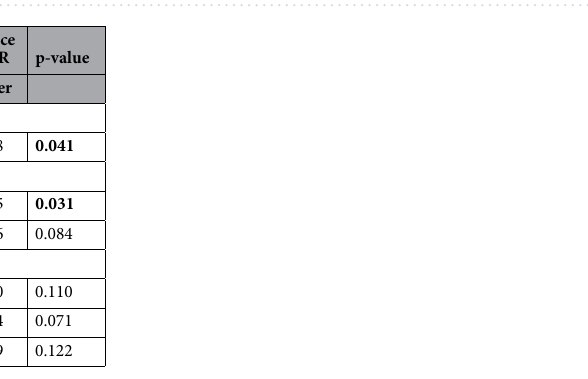
Figure 3. Total SRI, weekly SRI, and least square mean between relapse group and no relapse group. Total and Weekly SRI in relapsers (red) and non-relapsers (blue). ( A ). One-way plot showing total SRI (y-axis) in non- relapsers ‘0’ (N = 60, µ = 72.36, blue dots) and relapsers ‘1’ (N = 18, µ = 63.38, red dots) (x-axis). The line near the center of each green diamond in Fig. 1A represents the group mean for the specified group on the x-axis. Significant difference in total SRI between relapsers and non-relapsers (Independent samples t-test p = 0.007 ). ( B ). Overlay Box Plots of weekly SRI values (week 1, week 2, week 3, and week 4) in non-relapsers (blue dots) and relapsers (red dots). Red line indicates the weekly SRI average for relapsers and blue line indicates the weekly SRI averages of non-relapsers. Independent samples t-test at each week showed signficant difference at week 1 ( p = 0.01 ) and week 4 (p = 0.008 ). ( C ). Least square means over each week between relapsed and non- relapsed.